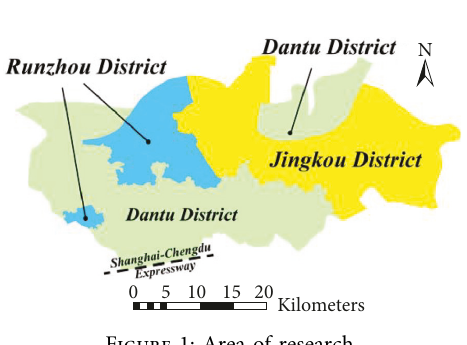
Figure 1: Area of research.